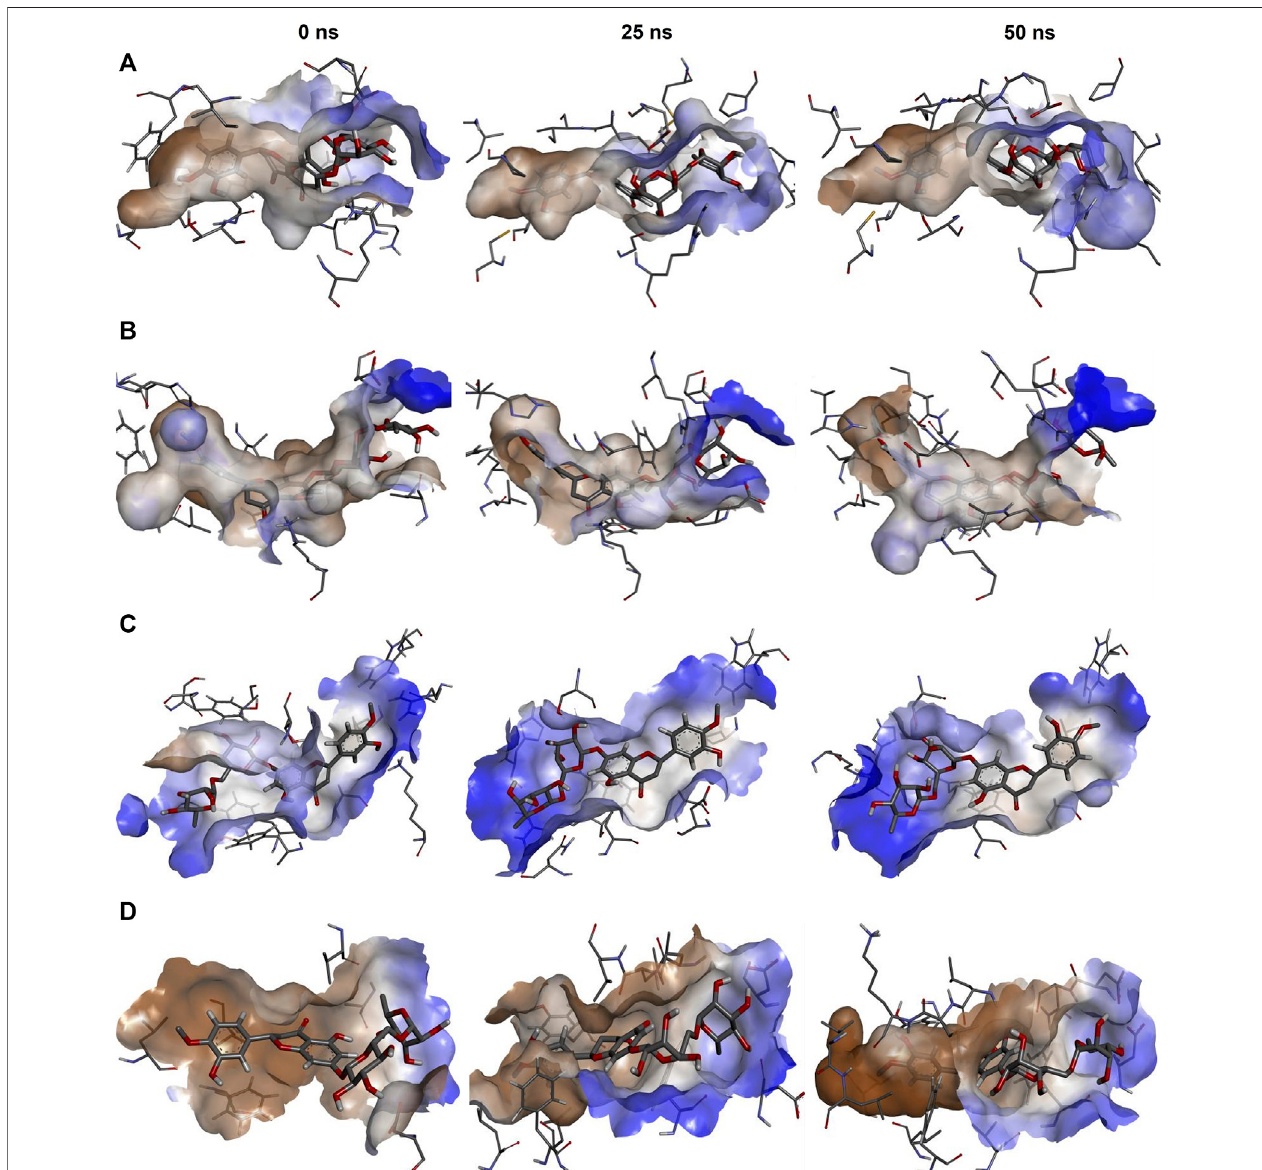
FIGURE2| Snapshotsofthecomplexesat0ns(start),25 ns(midway),and50 ns(end)ofthesimulationvisualisedinDiscoverystudio. (A) NMDAR-Hesperidin, (B) TRK-Hesperidin, (C) GABA-Hesperidin, and (D) Interleukin10-Hesperidin.